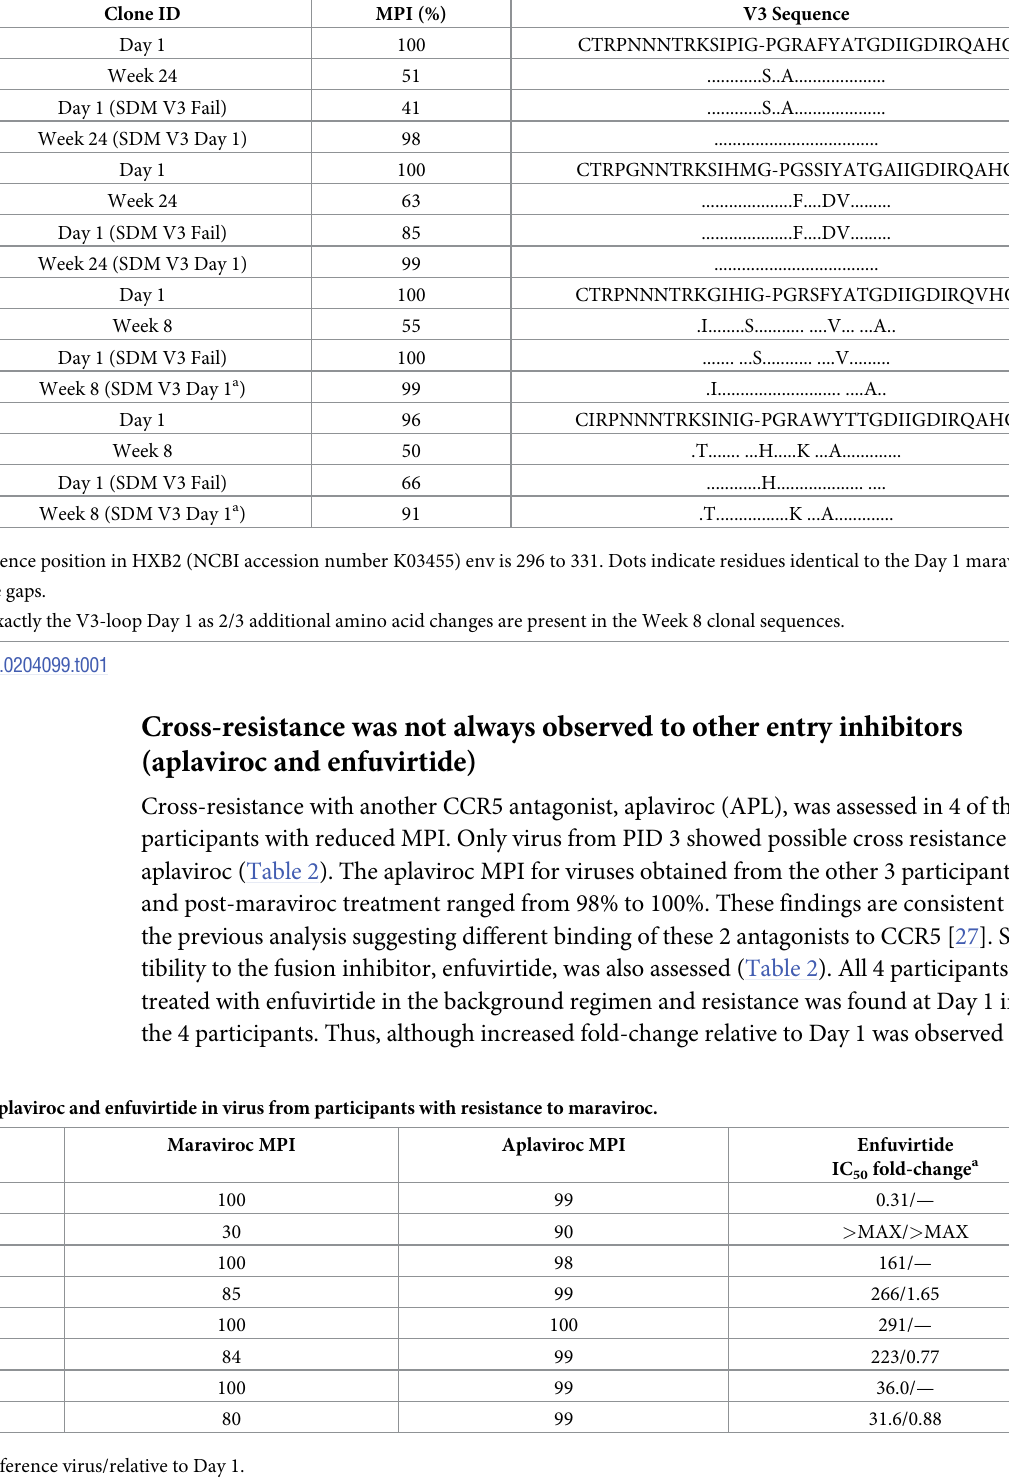
Table 1. Maraviroc susceptibility of parental and site-directed mutagenesis Env clones. Participant ID